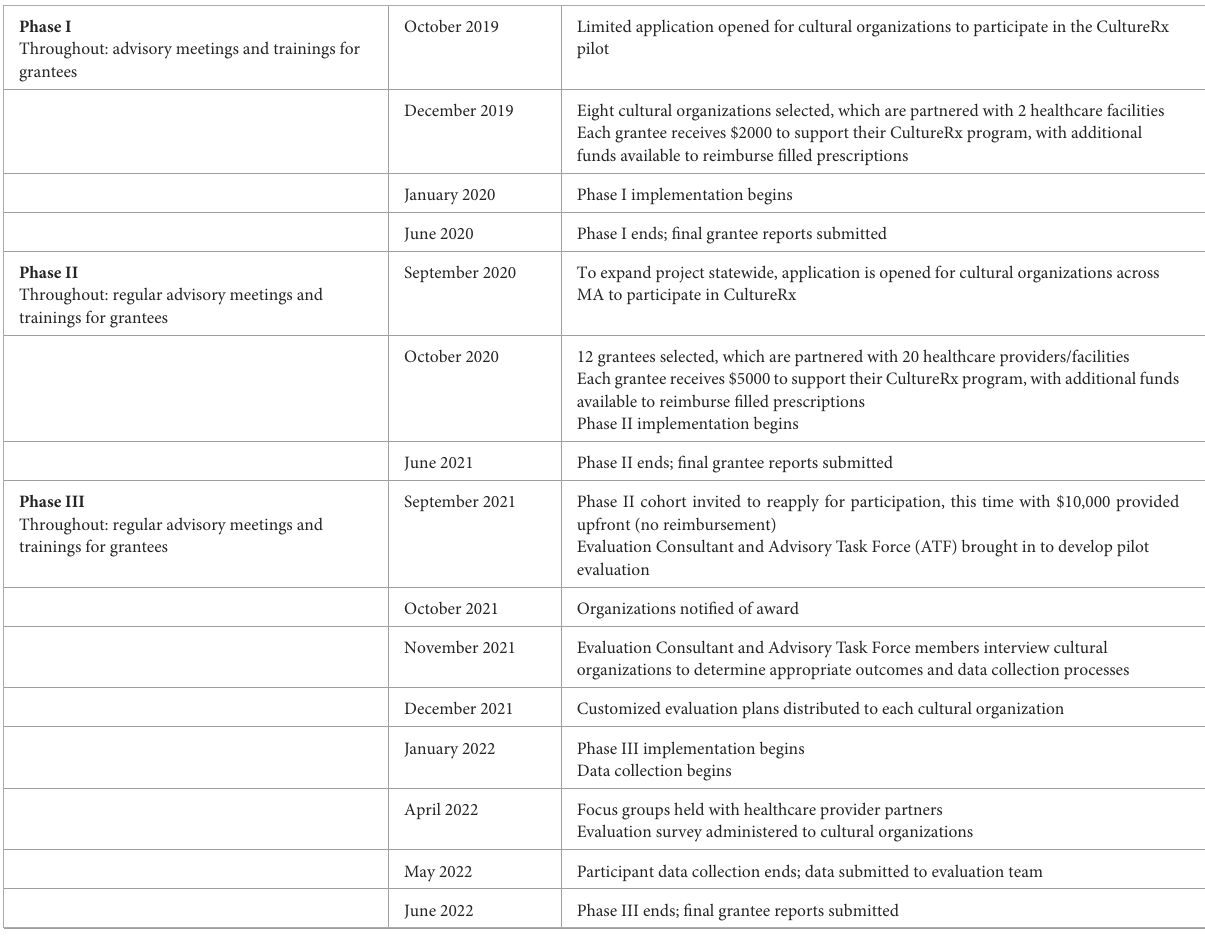
TABLE 1 “CultureRx: social prescription” program